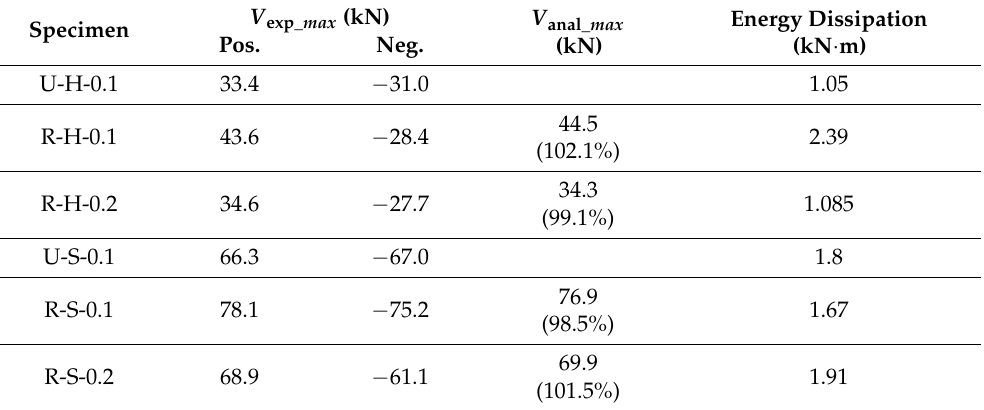
Table 2. Summary of experimental